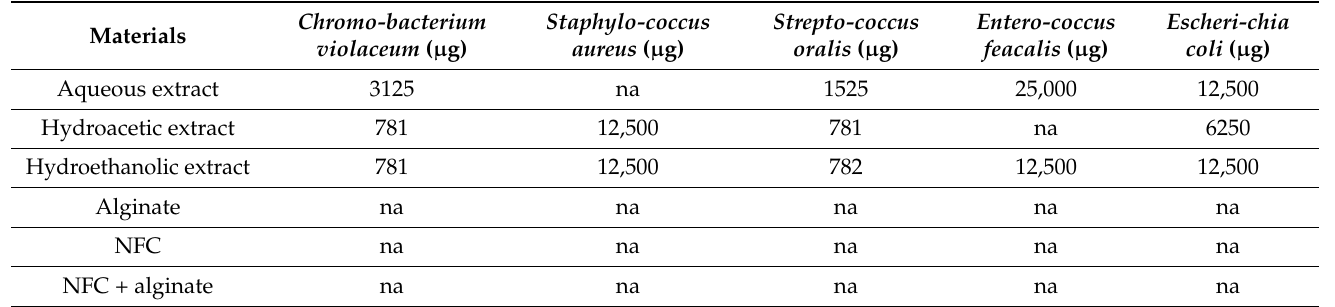
Table 1. Inhibitory effects of the TA extracts.